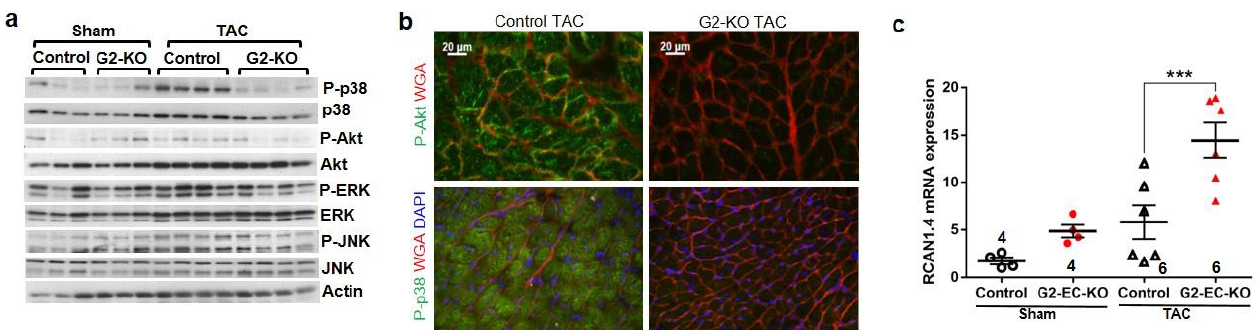
Figure 4. Regulation of cardiomyocyte signaling in endothelial GATA2 knock-out mice. ( a ) Immunoblots for indicated proteins of cardiac protein lysate 2 weeks after surgery. ( b ) Immuno-fluorescence of cardiac sections. ( c ) qPCR for RCAN1.4 mRNA from mouse hearts. Data are mean ± sem; the number of biological replicates is shown in the graphs; * p < 0.05, ** p < 0.01, *** p < 0.001, **** p < 0.0001.